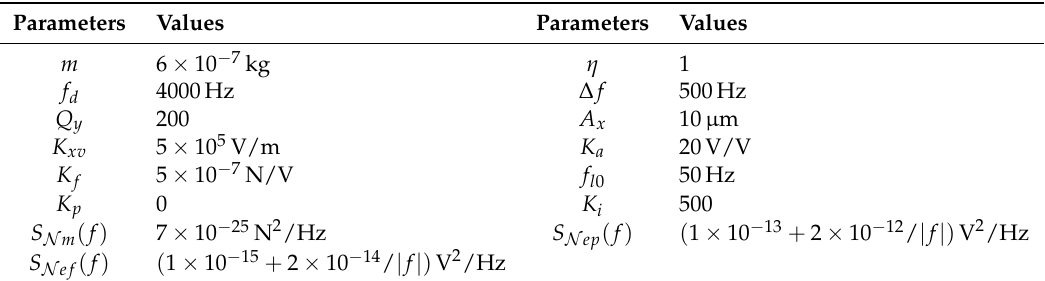
Figure 6. The PSD of the noise equivalent rate (NER) for different parameters in open-loop mode-split gyroscopes. Solid lines for the mechanical noise. Dashed lines for the electrical noise. ( a ) Comparisons between different ∆ f ; ( b ) Comparisons between different Q y . Table 1. Default values of the parameters used in numerical